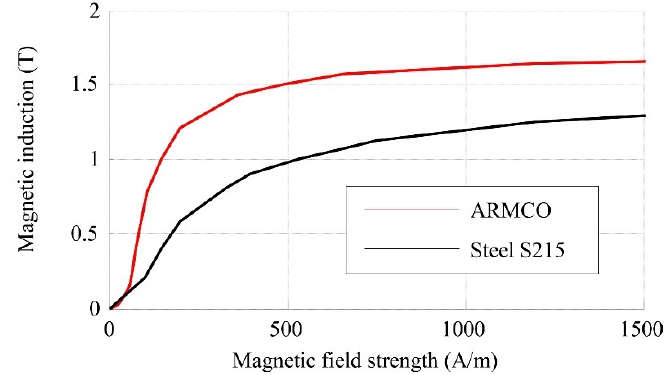
Figure 4. First magnetisation curves for ARMCO iron (steel 04J) and steel S215.